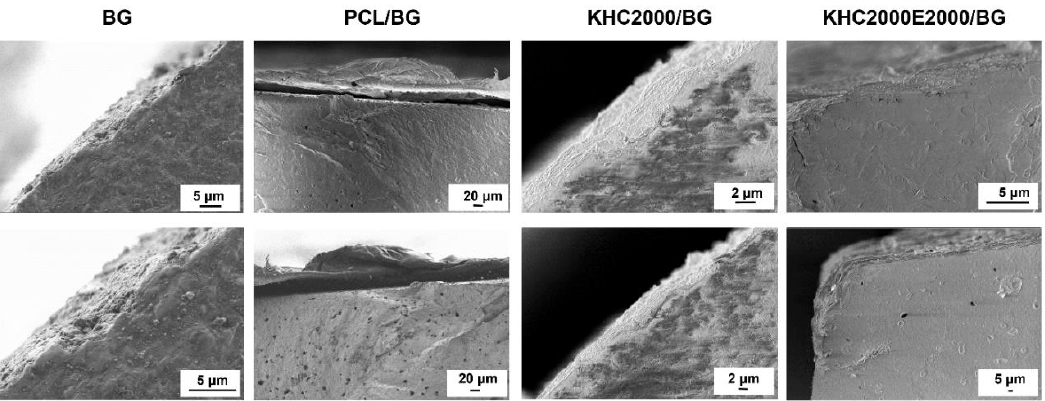
Figure 7. SEM images of the cross-sections of PCL-, KHC2000- and KHC2000E2000-coated pellets. SEM images of BG pellets are also reported as a control condition.